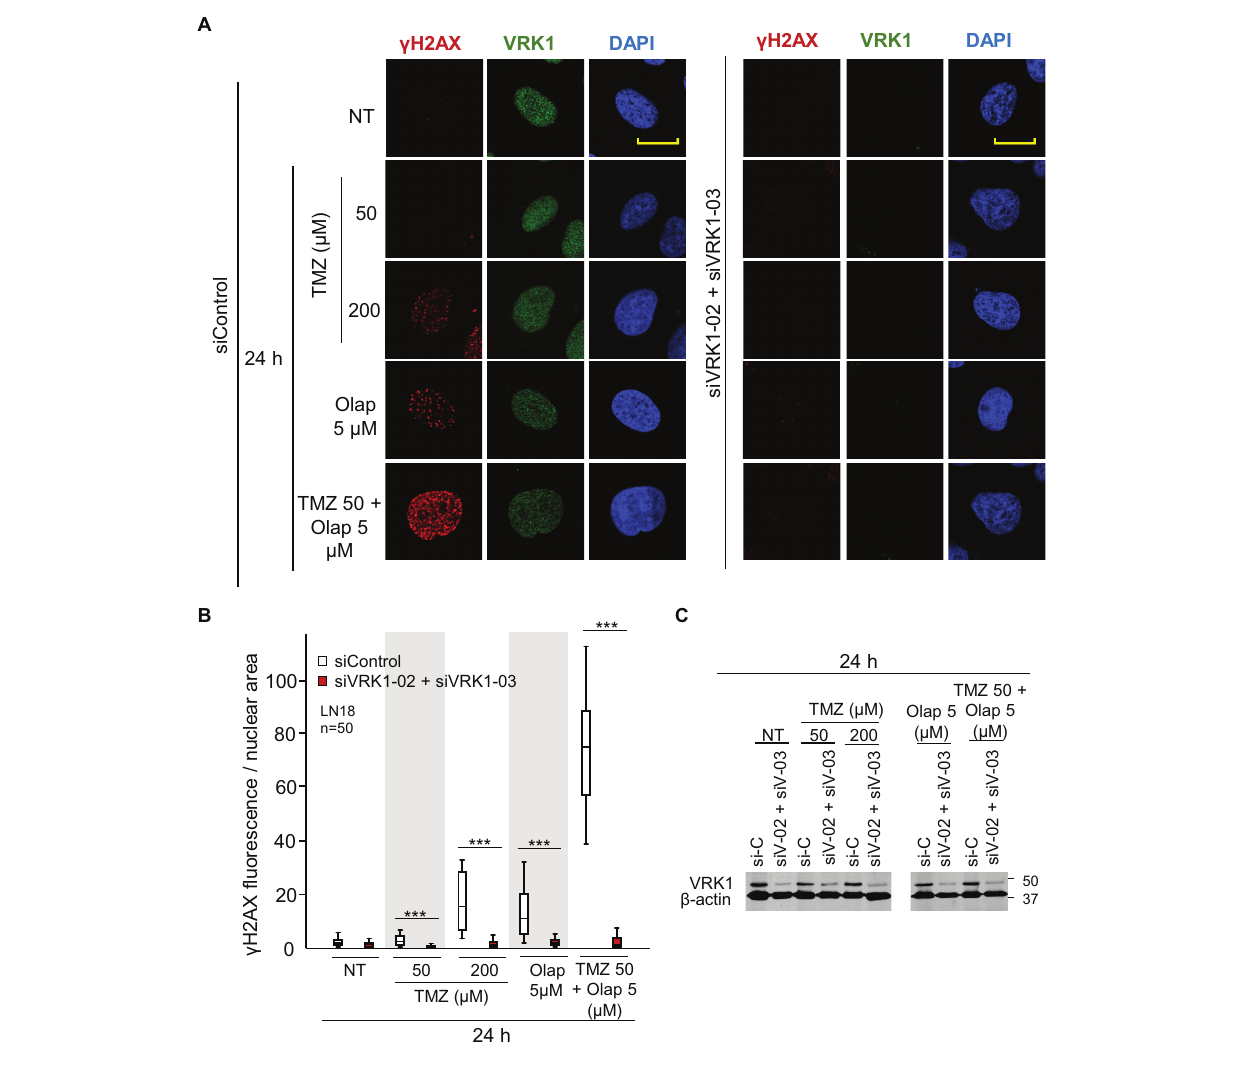
FIGURE 3 | Effect of VRK1 knockdown on γ H2AX foci formation after TMZ and olaparib treatments in LN-18 cells. (A) Left. Effect of siControl on γ H2AX foci formation induced by TMZ, olaparib and their combination. Right. Effect of the combination of siVRK1-02 and siVRK1-03 on γ H2AX foci formation induced by TMZ, olaparib and their combination. (B) Quantification of the effect of VRK1 depletion on γ H2AX fluorescence per nuclear area. Fifty cells per experiment in triplicate were quantified. NT: no treatment. Scale bar = 10 µ m. *** p < 0.001. Field images shown in Supplementary Figure 5 . (C) Western blot showing the effect of VRK1 knockdown. β -actin was used as load